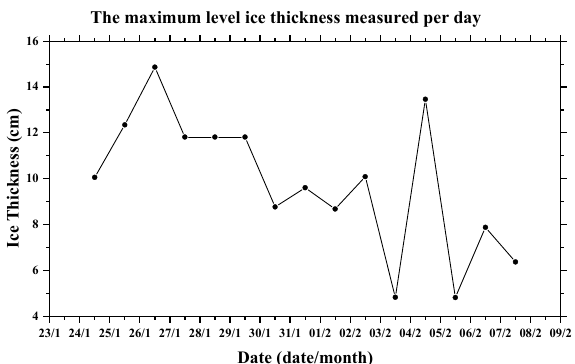
Figure 3. The maximum level ice thickness measured per day in January and February 2018.